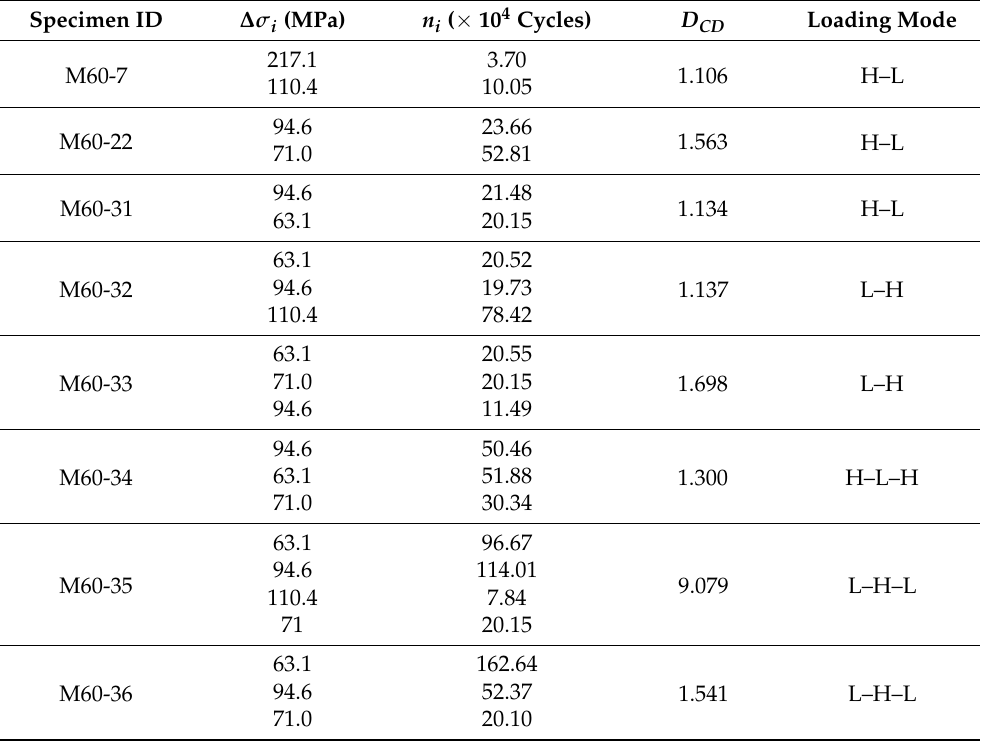
Table 4. The cumulative fatigue damage to the M60 high-strength bolts calculated using Corten– Dolan’s